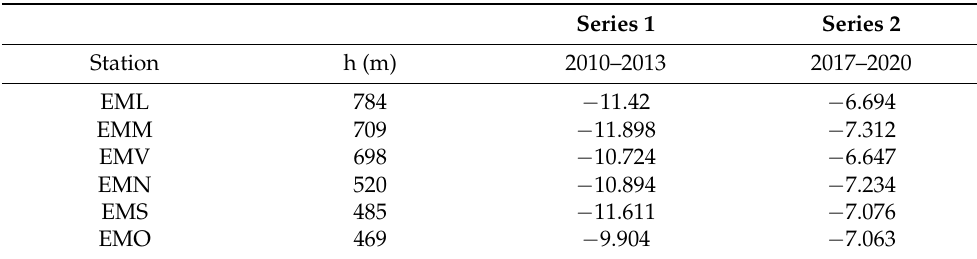
Figure 8 allows us to compare the periods with the greatest and least loss of